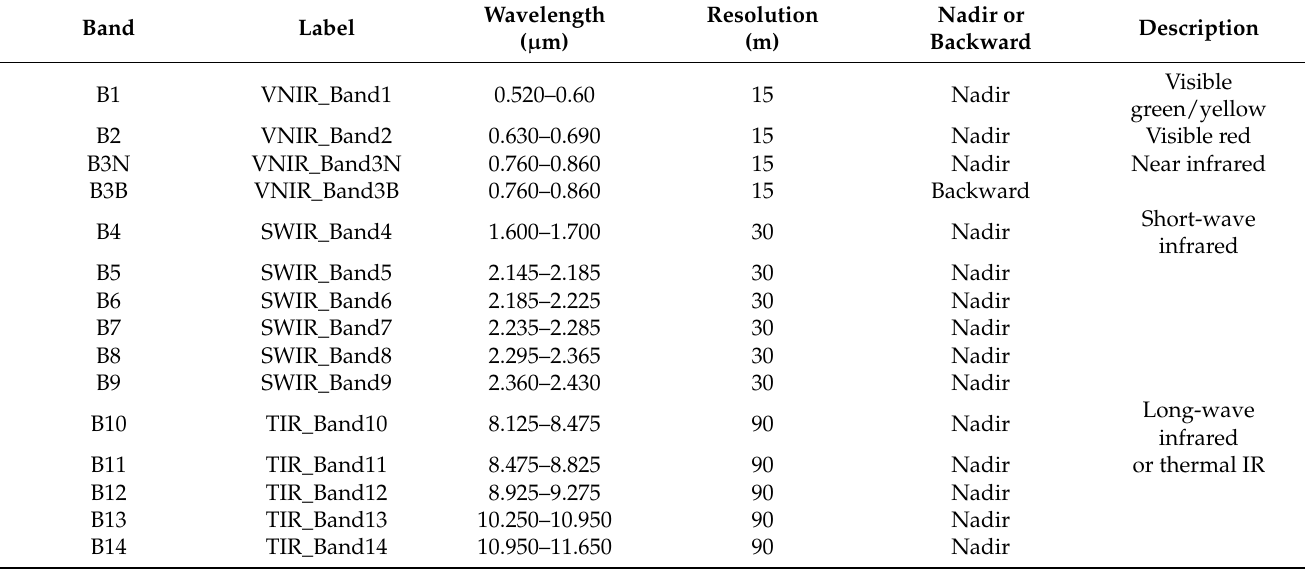
Table 3. Technical characteristics of ASTER